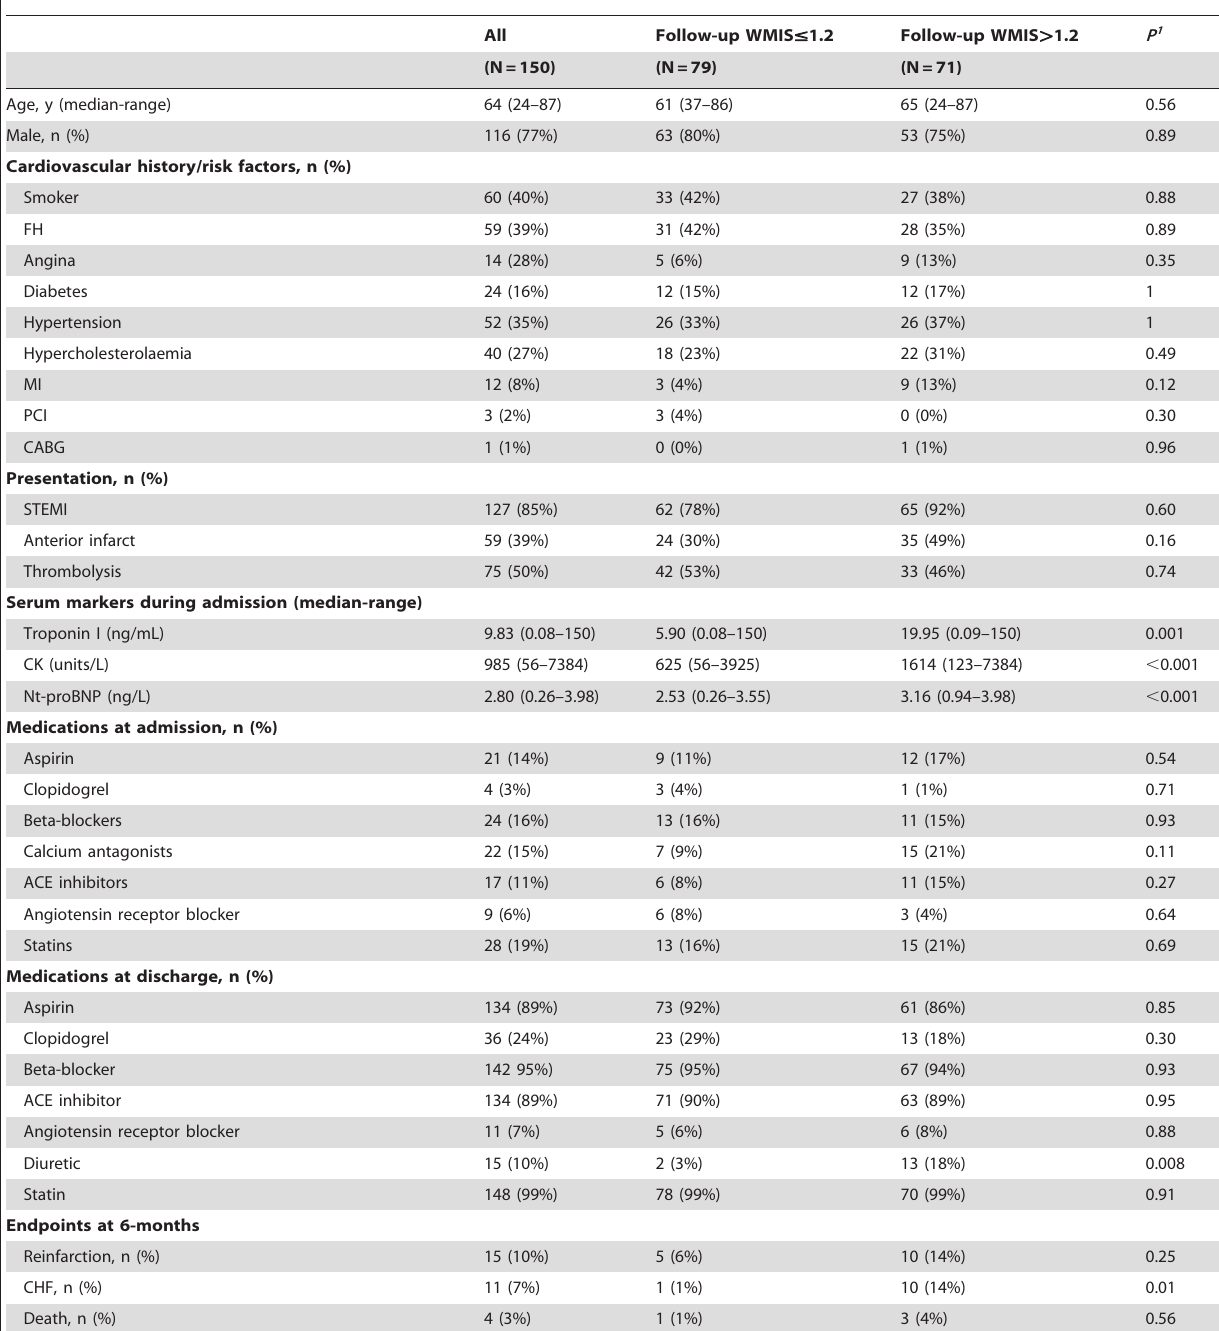
Table 1. Demographic and clinical features of AMI patients.